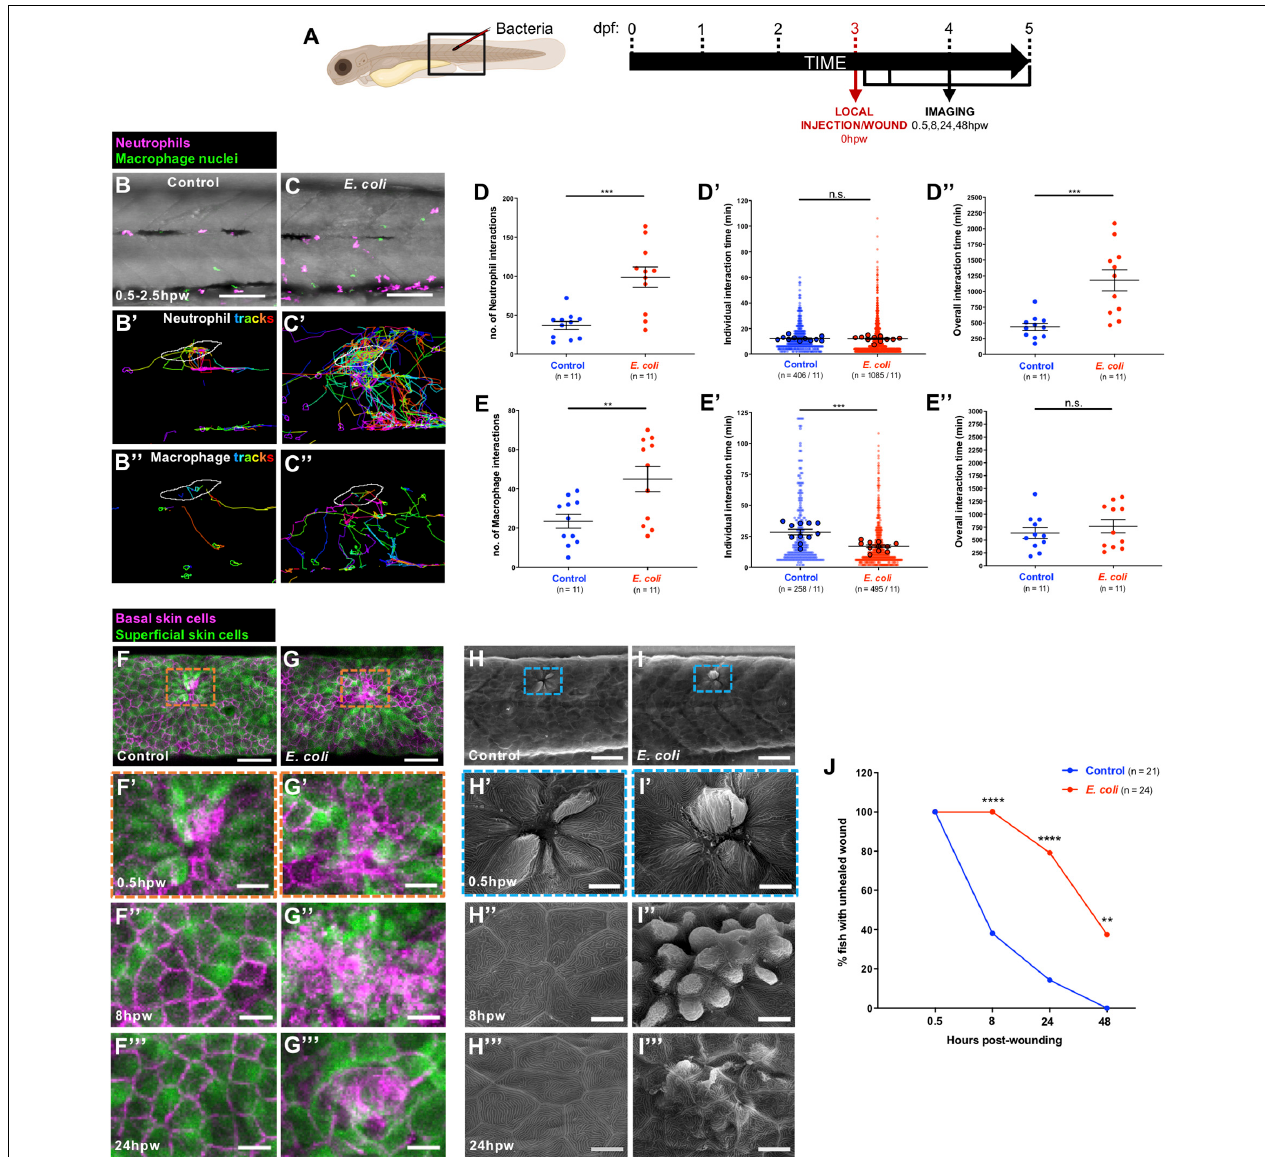
FIGURE 2 | Alterations to the wound inflammatory response upon E. coli infection and consequences for tissue repair. (A) Schematic of the experimental timeline for locally infected flank wound studies showing the region (black box) to be imaged in (B,C,F–I) . (B,C) Multi-channel confocal movie frames of flank wounded Tg( lyz:DsRed;mpeg1:nls-Clover ) larvae at 0.5 hpw after local injection of control media (B) or E. coli (C) , and prior to analysis of neutrophil (magenta) or macrophage (green nuclei) behaviour and their interactions with the wound. (B’,C’,B”,C”) Post-software images of the same larvae showing neutrophils (magenta) (B’,C’) or macrophage nuclei (green) (B”,C”) and their tracks towards the wound (white lines indicate wound margins). (D,E,D’,E’,D”,E”) Graphs showing number and individual/overall duration of neutrophil-wound (D,D’,D”) and macrophage-wound (E,E’,E”) interactions. (F,G) Multi-channel confocal images of flank wounded Tg( krt4:GFP;krt19:tdTomato-CAAX ) larvae showing the disposition of the larval zebrafish skin superficial (green) and basal (magenta) cell layers at 0.5 hpw in control (F) or E. coli -injected fish (G) . (H,I) Scanning electron micrographs of flank wounded larvae at 0.5 hpw after local injection of control media (H) or E. coli (I) . (F’–I’,F”–I”,F”’–I”’) Higher magnification views of wound regions from (F–I) at 0.5 hpw (F’–I’) , 8 hpw (F”–I”) , and 24 hpw (F”’–I”’) . (J) Graph showing rate of healing in infected vs. uninfected wounds. Scale bars = 100 µ m in (B,C) , 75 µ m in (F,G) , 50 µ m in (H,I) , 20 µ m in (F’,G’,F”,G”,F”’,G”’) , 10 µ m in (H’,I’,H”,I”,H”’,I”’)